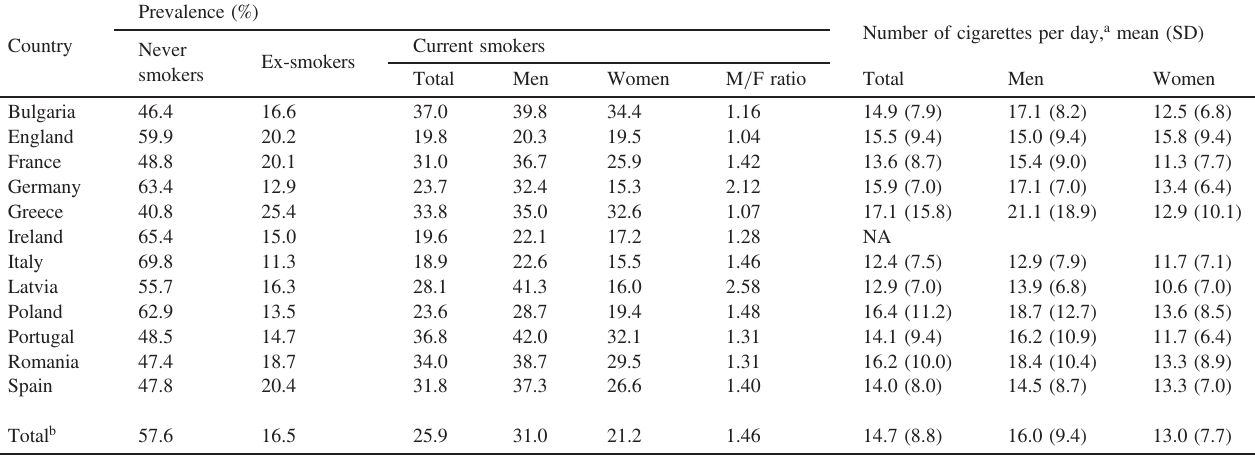
Number of cigarettes per day, a mean (SD)